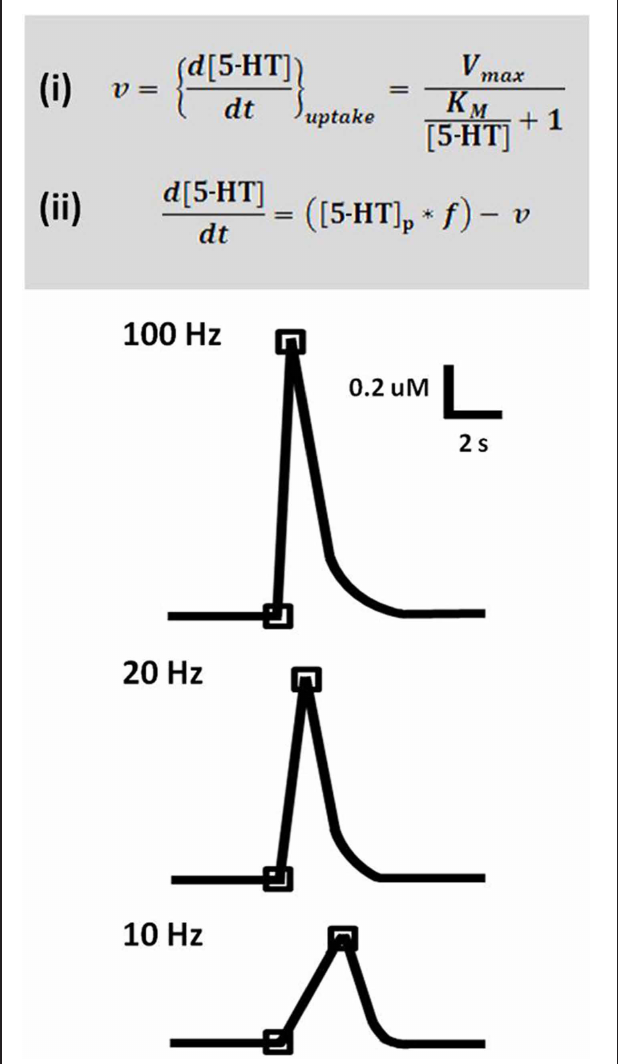
FIGURE 3 | A model predicts serotonin release and uptake at different frequencies. Top panel: Equation (i) describes rate of uptake ( v ) as a function of maximal uptake rate ( V max ), the Michaelis constant for SERT ( K M ), and concentration of released serotonin ([5-HT]). Equation (ii) describes the expected concentration of released serotonin given a stimulation with number of pulses (p) and frequency ( f ), less the uptake that occurs over this time period. Lower panel: Concentration evoked by 50 pulse stimulation trains at 100, 20, and 10Hz, as predicted by the model. Traces are representations of data based on Bunin et al. (1998).